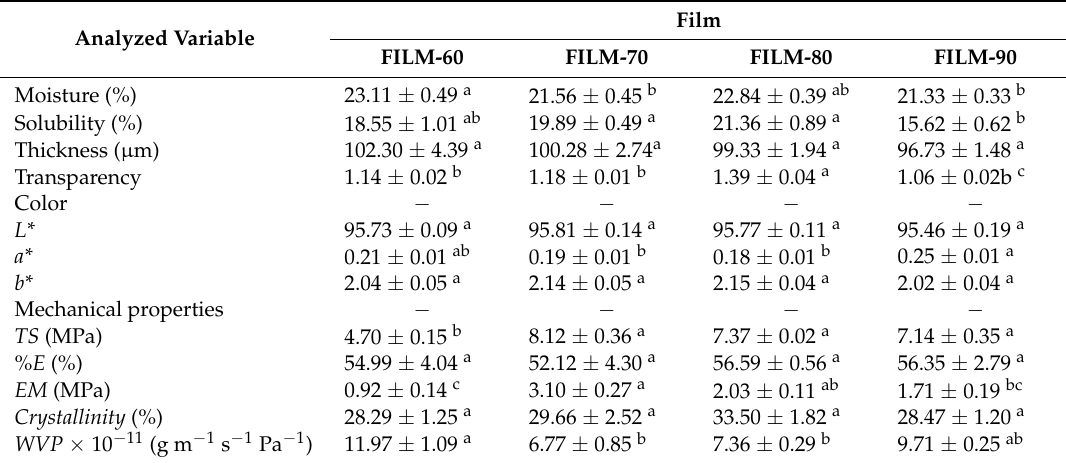
Table 1. Physical, mechanical, crystallinity and water vapor permeability (WVP) properties of apple starch films harvested at different days after full bloom